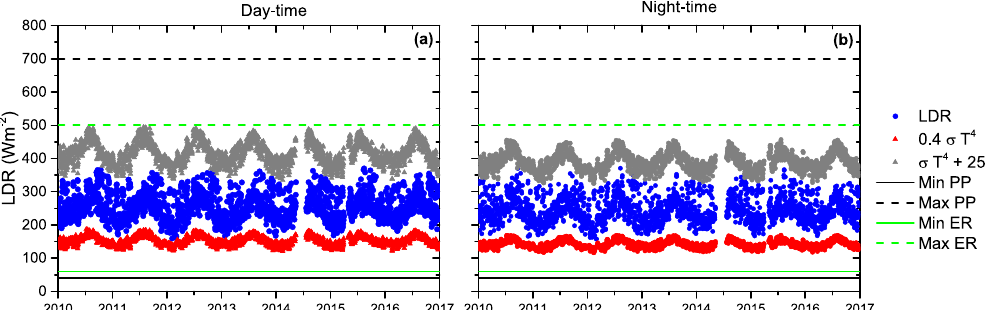
Figure 1. The LDR time series obtained at (a) daytime and (b) night-time with a CG(R)4 pyrgeometer between 2010 and 2016 at IZO BSRN (blue dots). The black and green lines represent the physically possible (Min PP, Max PP) and extremely rare limits (Min ER, Max ER), respectively; the grey and red dots represent the upper ( σT 4 + 25) and lower (0.4 σT 4 ) limits, respectively, where σ is Stefan–Boltzmann constant (5.67 × 10 − 8 Wm − 2 K − 4 ) and T is the air temperature in K.